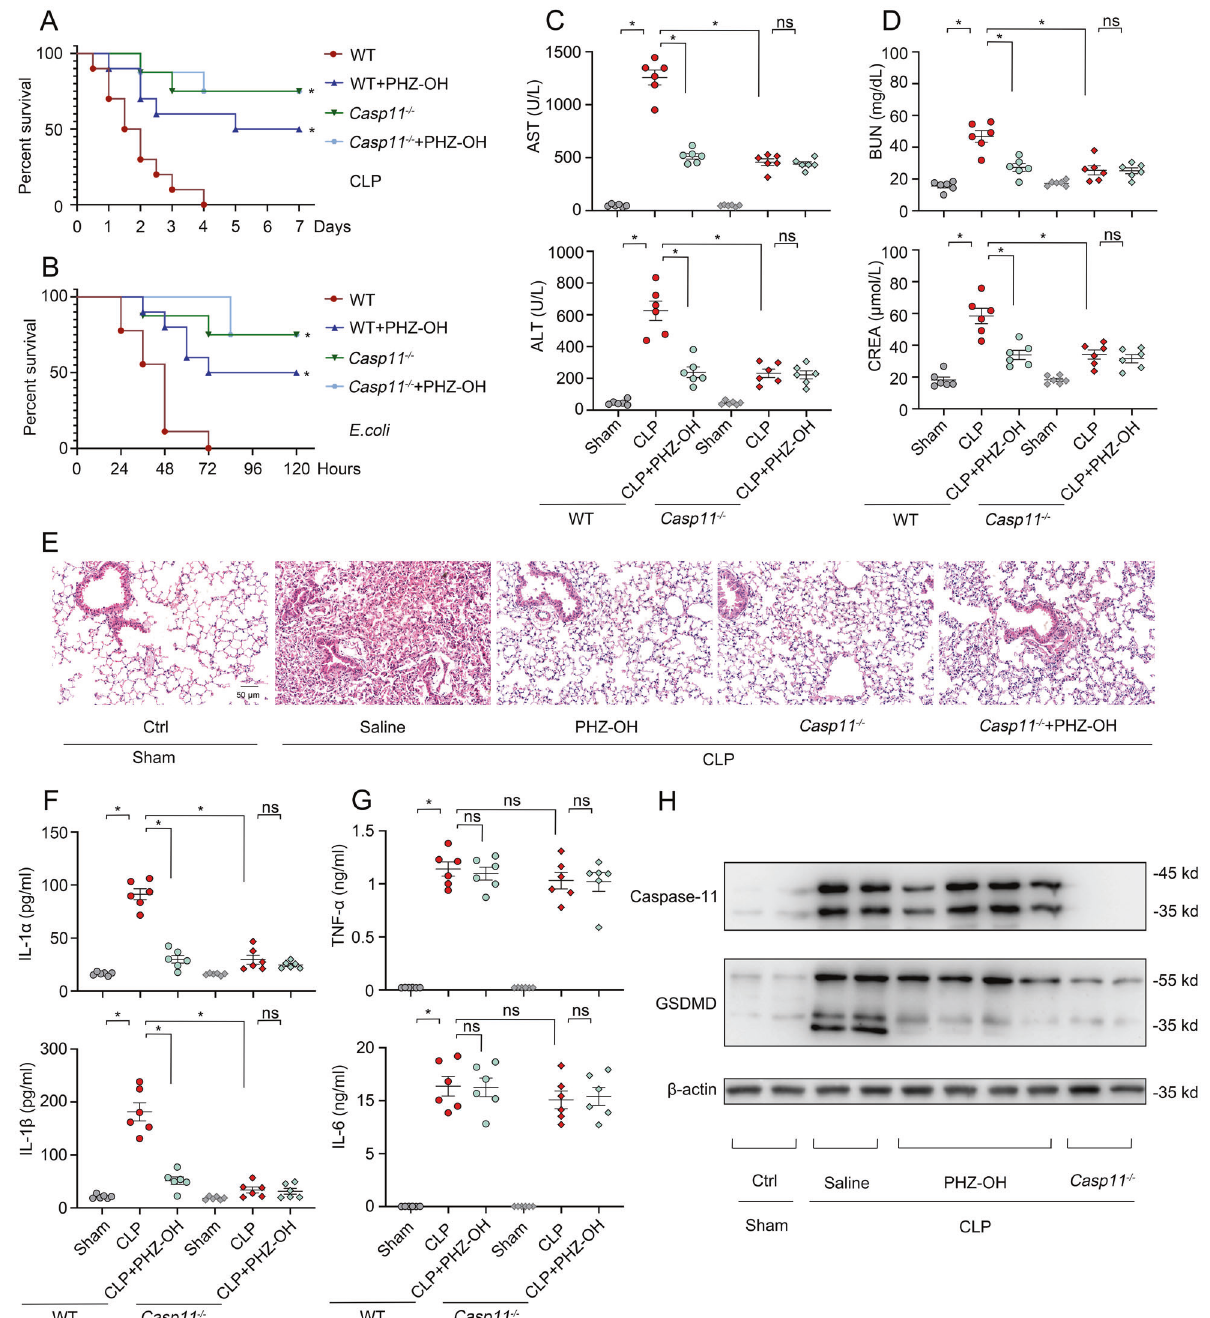
Fig. 2 PHZ-OH attenuates organ dysfunction in bacterial sepsis via inhibiting caspase-11 signaling. Survival curves of WT and Casp11 − / − mice treated with saline or PHZ-OH (5 mg/kg) and subsequently challenged with cecal ligation and puncture (CLP, ligating 75% of the cecal) ( A ) or E. coli (ATCC 29522, 10 9 CFU per mice) ( B ); C – H WT and Casp11 − / − mice were treated with saline or 5 mg/kg of PHZ-OH 30 min prior to a challenge of CLP (ligating 75% of the cecal) or not (six mice per group). The plasma, the lung and the liver were sequentially harvested 12 h after the challenge of CLP, and stored for further experiments. Variations of plasma-associated parameters including aspartate aminotransferase (AST) and alanine transaminase (ALT) ( C ), and blood urea nitrogen (BUN) and creatinine (CREA) ( D ); E Hematoxylin and Eosin (H&E) staining of the lung; Plasma levels of IL-1 α and IL-1 β ( F ), and TNF α and IL-6 ( G ); H Western blots showing caspase-11 expression and GSDMD cleavage in the liver (representative of six mice per group). Data are mean ± SEM of six mice in one experiment. * P < 0.05. ns, not signi fi cant. Scale bar = 50 μ